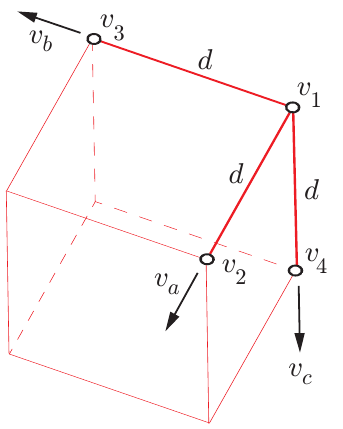
Figure 2. Optimal antenna configuration with four